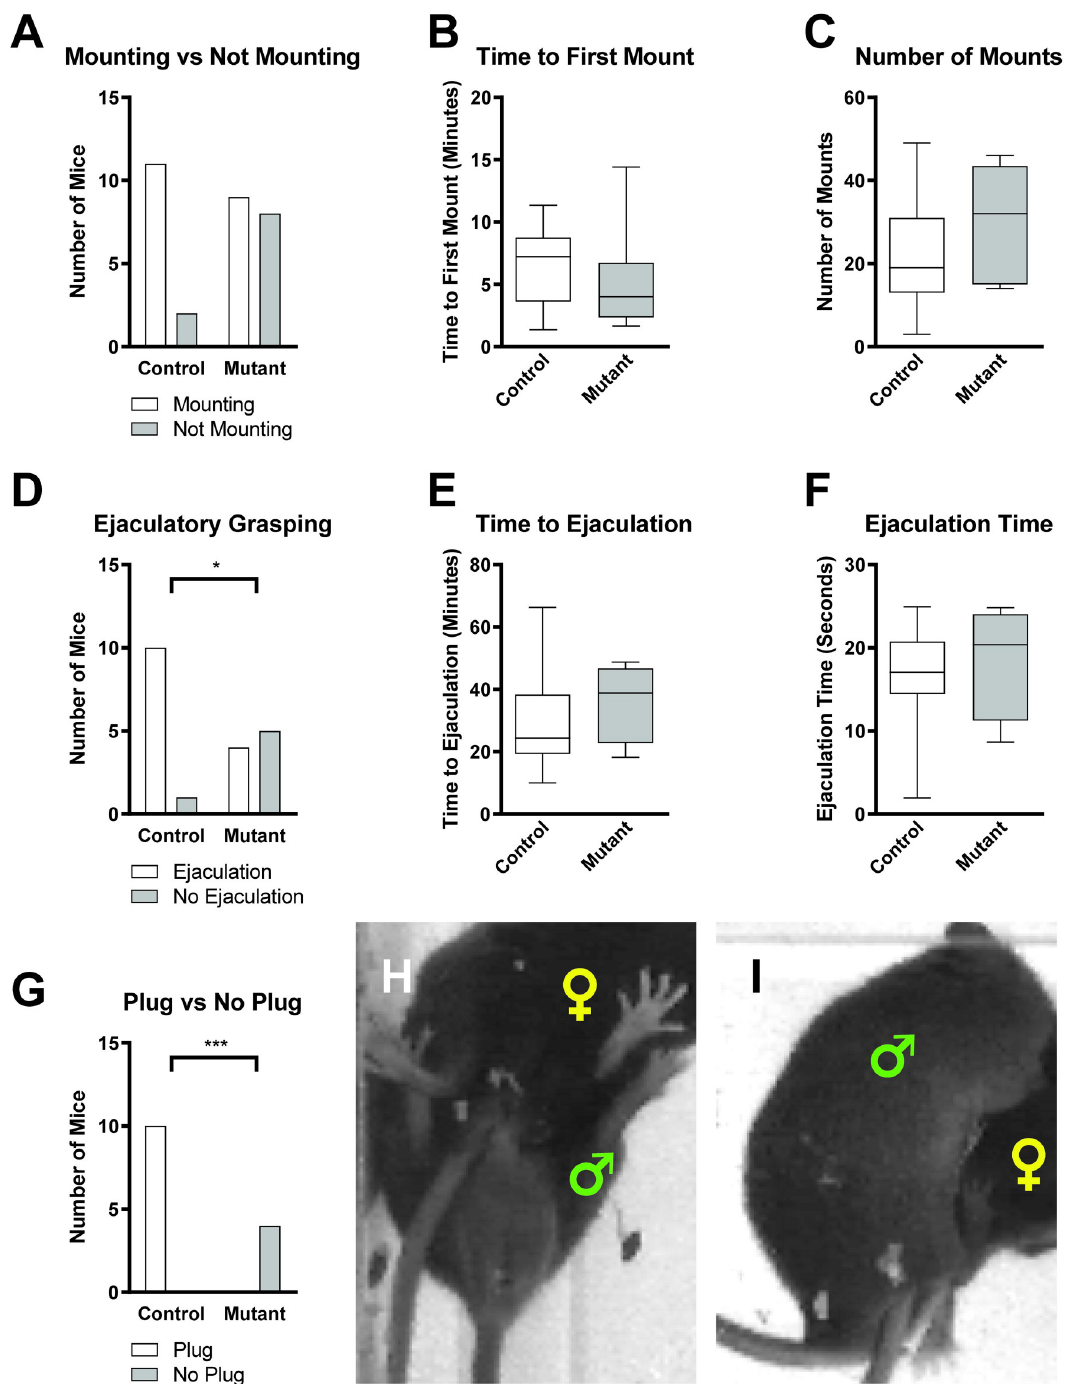
Fig 2. Pea3 null mice exhibit deficiencies in ejaculatory behaviors. (A) The number of mice that perform mounting behaviors is not statistically significant between control and Pea3 null mice (control: N = 13 mice; null: N = 17 mice; Fisher’s exact test, p < 0.1194). (B and C) There is no difference between control and Pea3 null mice in time to first mount (B: control: 6.32 ± 0.93 minutes, N = 11; null: 5.05 ± 1.37 minutes, N = 9; Mann-Whitney test, p < 0.2947) and the number of mounts performed (C: control: 21.45 ± 4.25 mounts, n = 11; null: 29.44 ± 4.49 mounts, N = 9; Student’s t-test, p < 0.2142). (D) Fewer Pea3 null mice perform the ejaculatory grasping behavior compared to control mice (control: N = 11 mice; null: N = 9 mice; Fisher’s exact test, p < 0.0498, � ). (E and F) There is no difference between control and Pea3 null mice in time to ejaculatory grasping (E: control: 30.01 ± 5.04 minutes, N = 10 mice; null: 36.16 ± 6.47 minutes, N = 4 mice; Mann-Whitney test, p < 0.5395) and the duration of ejaculatory grasping (F: control: 16.41 ± 1.97 seconds, N = 10 mice; null: 18.58 ± 3.51 seconds, N = 4 mice; Mann-Whitney test, p < 0.4535). (G) Of mice that